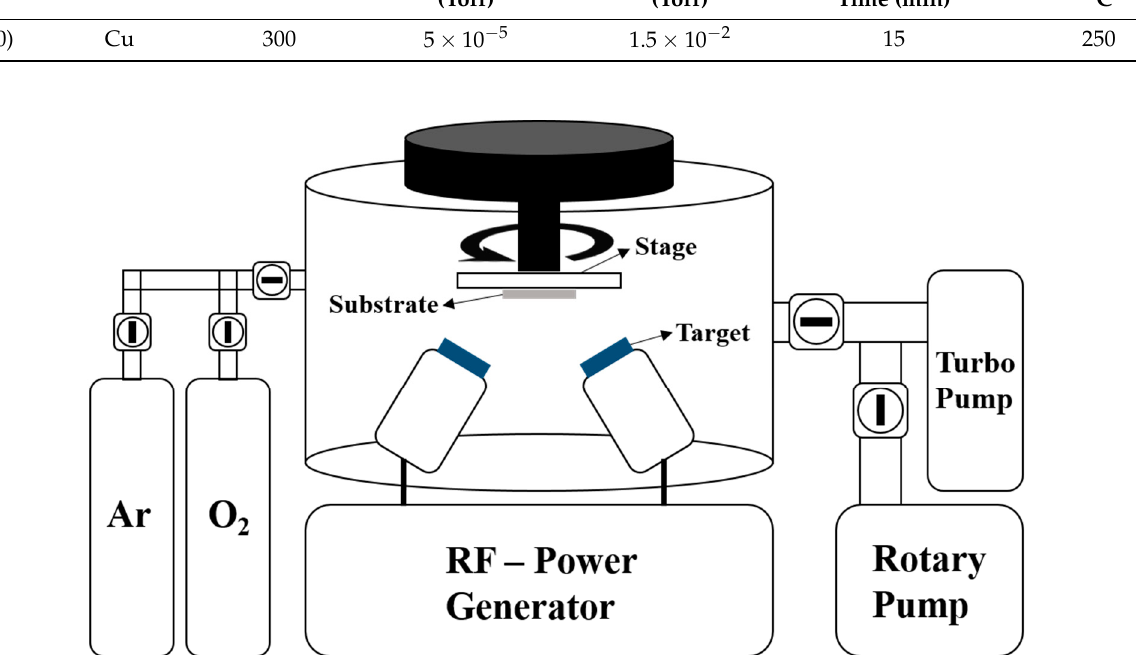
Figure 1. Schematic diagram of the RF magnetron sputtering system used in this study to synthesize Cu and ZnO.